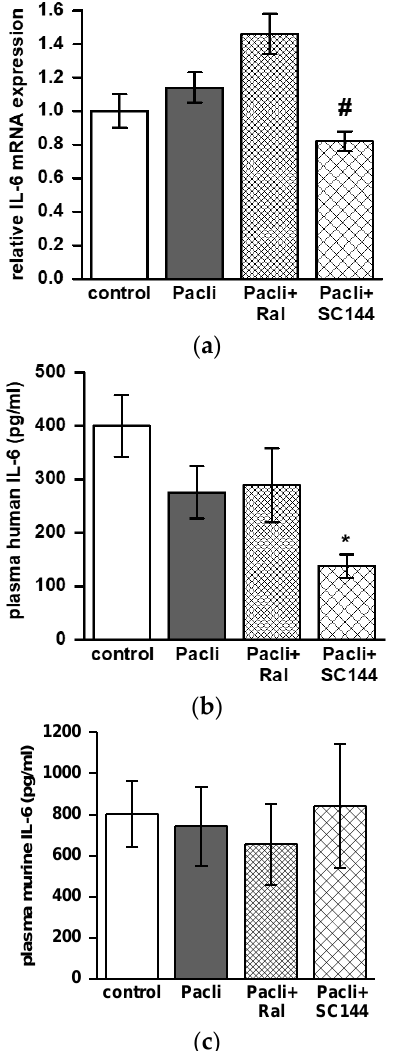
Figure 6. Combined drug treatment with raloxifene/paclitaxel or SC144/paclitaxel changes IL-6 expression in mouse tumors and plasma. ( a ) The graph shows relative mRNA expression level of IL-6 in mouse tumors (n = 4–9). Data obtained from ELISA measurements are given as mean ± SEM and show ( b ) human IL-6 concentration and ( c ) murine IL-6 concentration in mouse plasma (n = 6–12). * p < 0.05 versus control; # p < 0.05 versus paclitaxel.